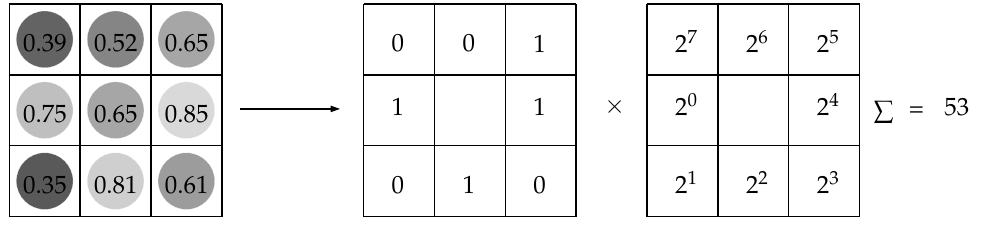
Figure 11. Local binary patterns.